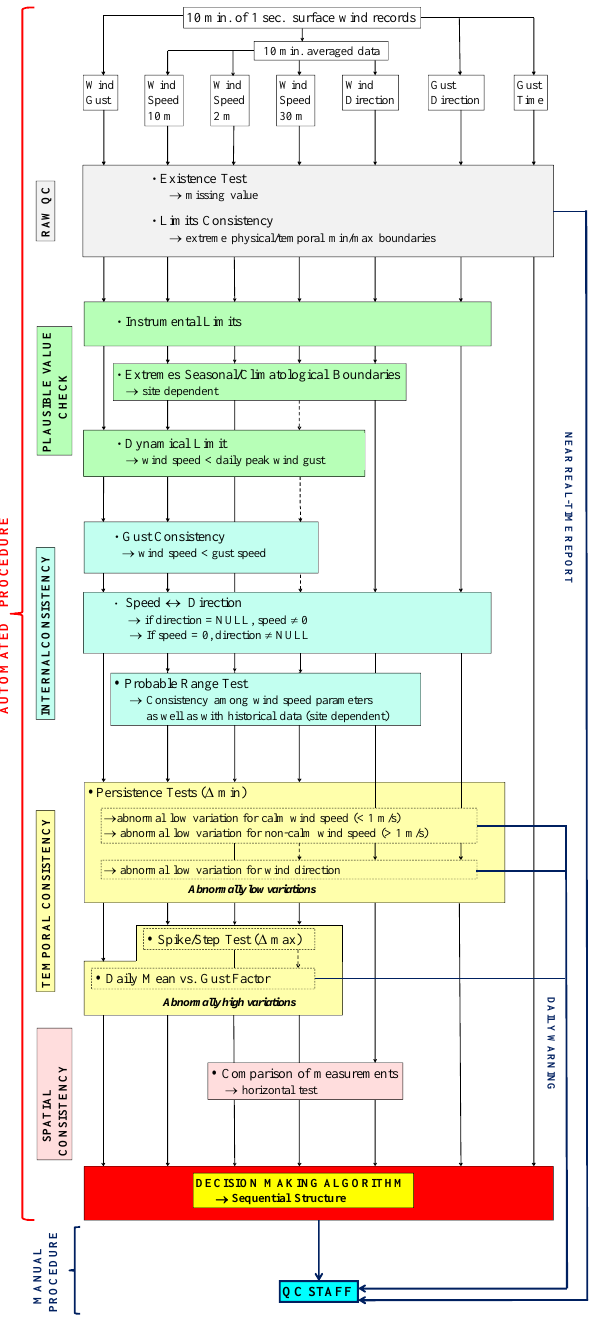
Figure 2. Flowchart of the wind quality assurance process imple- mented at RMI. (Dashed arrow only applies to 30m wind measure- ments in Uccle –